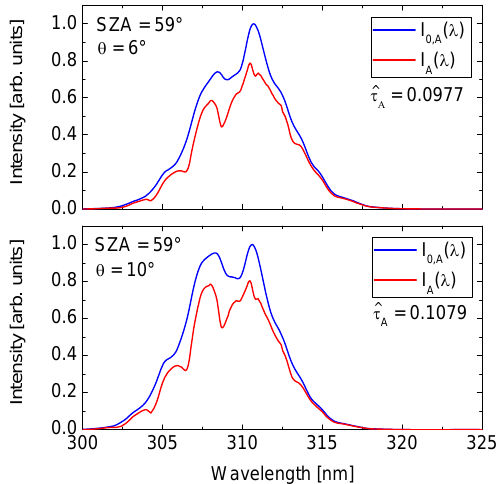
Fig. 6. Modeled light intensity I A passing filter A of the SO 2 cam- Figure 6. Modeled light intensity I A passing filter A of the SO 2 camera as a function of 6 era as a function of wavelength λ for two different illumination an- wavelength λ for two different illumination angles ( θ = 6° and θ = 10°). The blue curve ( I 0,A ) 7 gles ( θ = 6 ◦ and θ = 10 ◦ ). The blue curve ( I 0 ,A ) assumes no SO 2 in assumes no SO 2 in the optical path (background spectrum), while the red curve ( I A ) represents 8 the optical path (background spectrum), while the red curve ( I A ) an SO 2 column density S of 400 ppmm. In both cases, the solar zenith angle (SZA) was kept 9 represents an SO 2 column density S of 400ppmm. In both cases, at 59°. The ratio of integrated intensity under the background spectrum and under the 10 the solar zenith angle (SZA) was kept at 59 ◦ . The ratio of inte- measurement spectrum yields the indicated integrated optical density τ ˆ A according to 11 grated intensity under the background spectrum and under the mea- surement spectrum yields the indicated integrated optical density Equation (7). The two integrated optical densities τ ˆ A are 9% and 20% higher than for 12 ˆ τ A according to Eq. 7. The two integrated optical densities ˆ τ A are perpendicular illumination (compare to Figure 4 (top)). 13 9% and 20% higher than for perpendicular illumination (compare to Fig. 4,